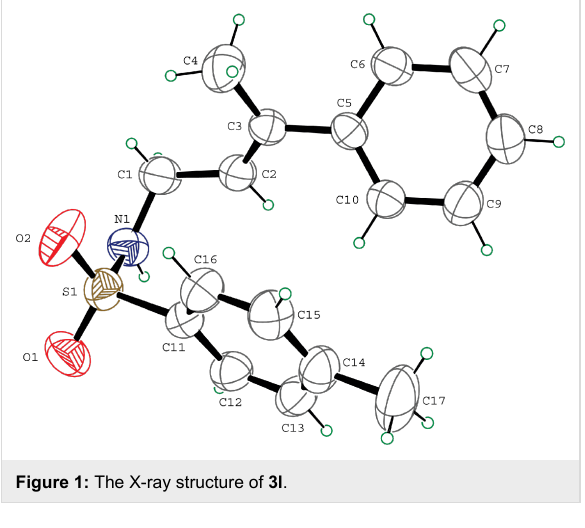
Figure 1: The X-ray structure of 3l .